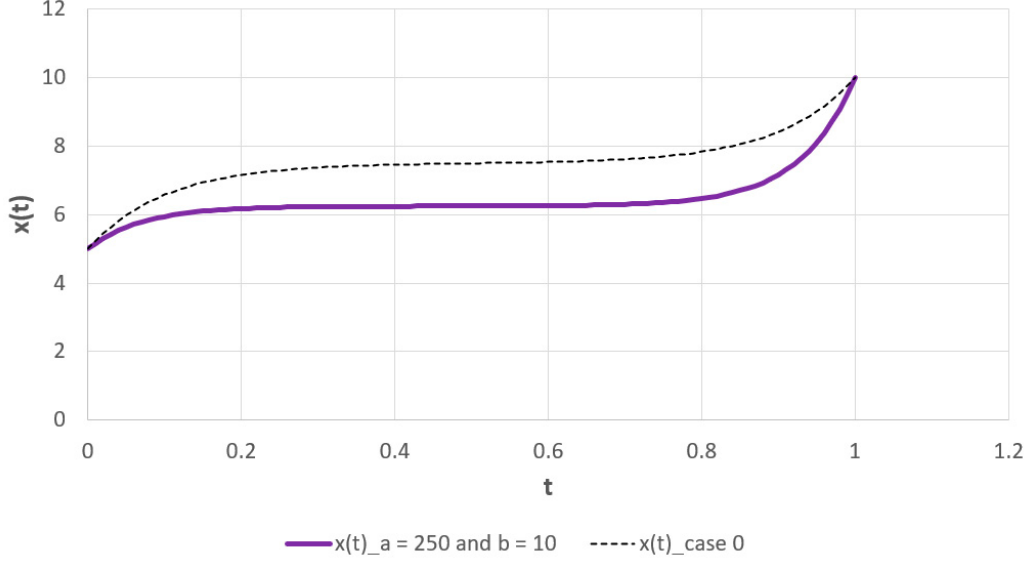
Figure 16. The optimal time path of x in Dynamic case 3.